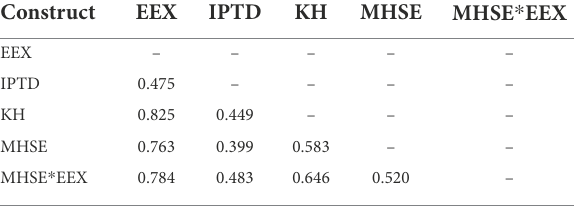
TABLE 8 Discriminant validity (HTMT; moderation).